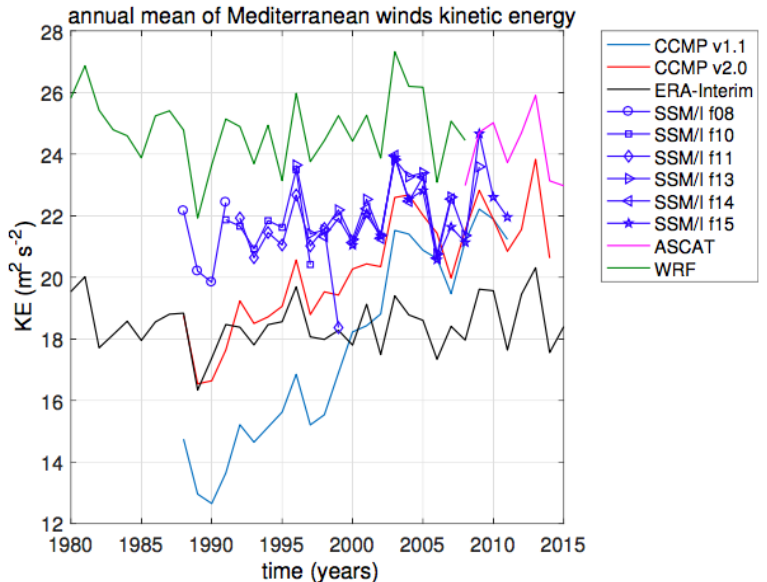
Figure A1. Annual mean of specific kinetic energy of surface winds averaged over the Mediterranean basin, from different sources. We compare results from the CCMP v1.1 (light blue) and v2.0 (red) products against ERA-Interim (black) data, radiometer (blue, for different instrument each covering a different time period) and scatterometer (magenta) data. We present also the results obtained by a high resolution 30 years long run with WRF in non-hydrostatic setup and forced by ERA-Interim data